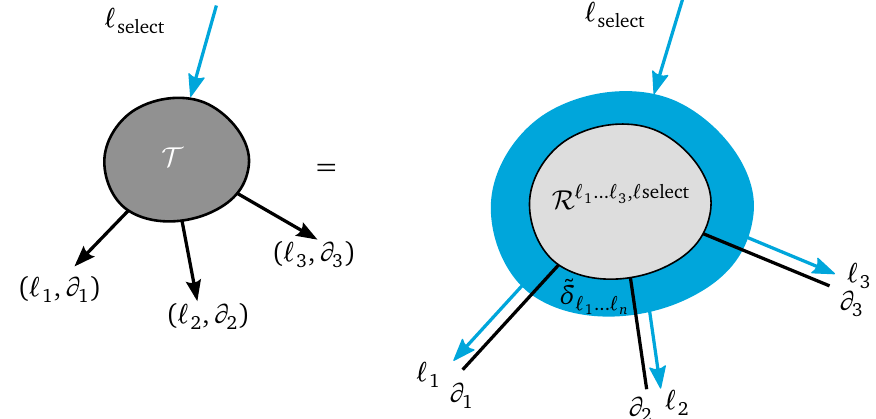
Figure 14: A covariant symmetric tensor is a symmetric (invariant) tensor with one link being a quantum-number selector link. This special link holds only a single, non-degenerate quantum number (cid:96) the usual form ˜ δ (cid:96)